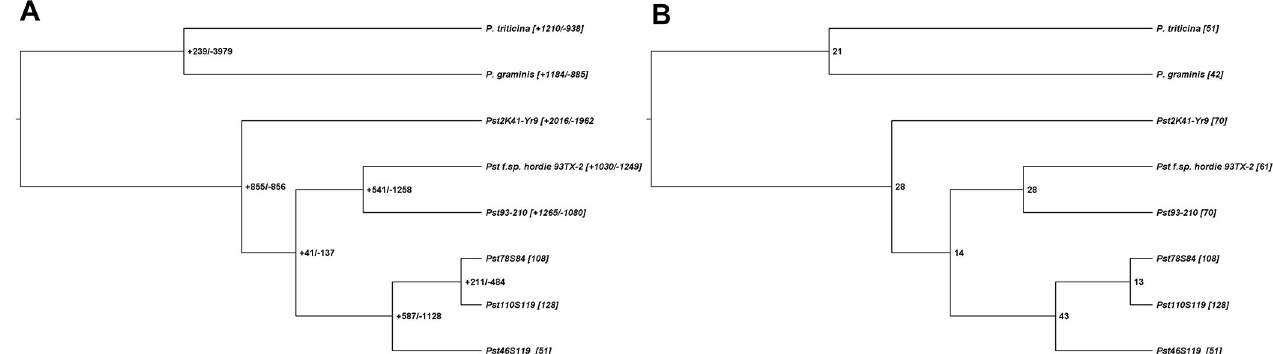
Fig 4. Evolution of gene families A) Gene gain and gene loss at the nodes and tips in five isolates of Puccina striiformis tritici , one isolate of each P . striiformis from barley, P . triticina and P . graminis tritici . Numbers in square bract shows the gene family gain (positive) and gene family loss (negative) B) Rapidly evolving gene families identified with CAFE´ among the